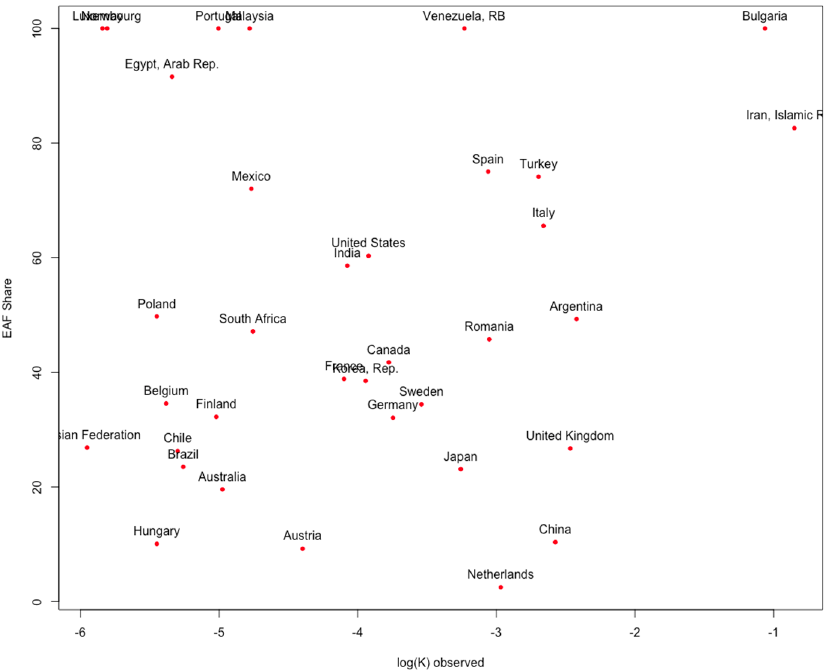
Figure 2. Observed values of the parameter K and share of the EAF technology in 2011.